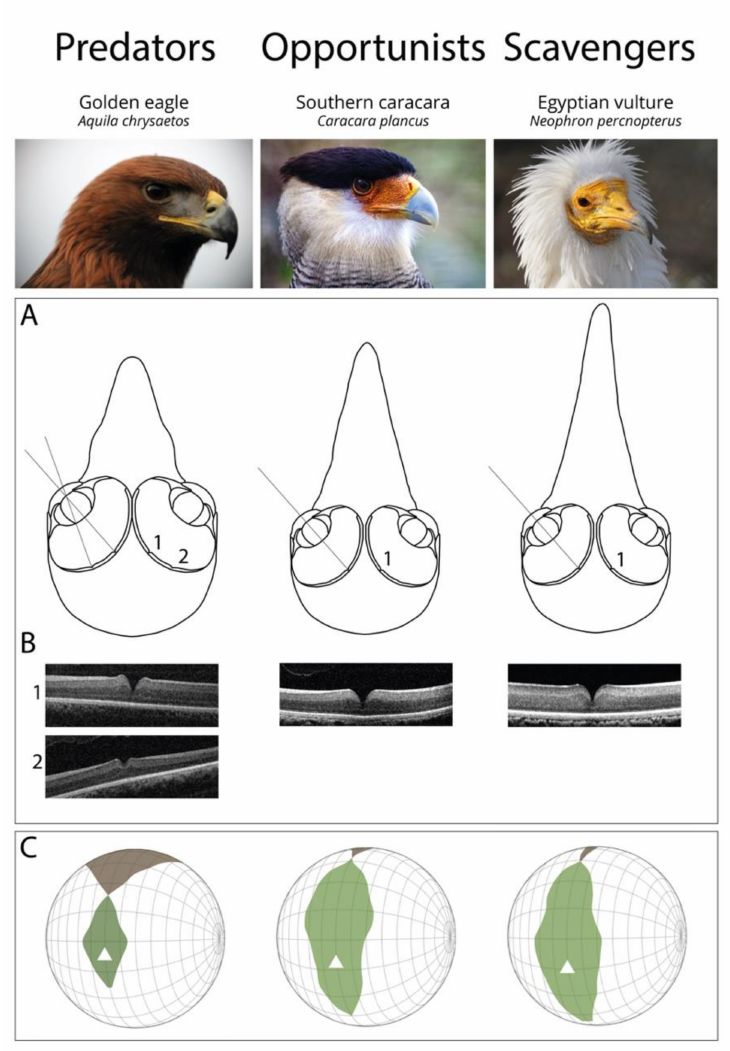
Figure 2. Functional di ff erences of the visual system of raptors from di ff erent foraging tactics. ( A ) Schematic representation of frontal sections of the three chosen species (Golden eagle Aquila chrysaetos , Southern caracara Caracara plancus , and Egyptian vulture Neoprhon percnopterus ) at the foveal plane. Fovea(s) and the centre of the pupil in each eye are on the plane. Grey lines represent the lines of sight of (1) the deep central fovea and (2) the shallow temporal fovea. Figures re-drawn from [28]. ( B ) Spectral domain optical coherence tomography (SD-OCT) images (B-scans) of the (1) central and (2) temporal fovea(s). Note that the Southern caracara and the Egyptian vulture lack temporal foveas. ( C ) Orthographic projection of retinal field boundaries of the eyes. A latitude and longitude coordinate system was used with the equator aligned vertically in the median sagittal plane (20 deg intervals in latitude and 10 deg intervals in longitude). The bird’s head is at the centre of the globe. Green areas represent the binocular sector, white areas represent the monocular sectors, and brown areas represent the blind sectors. Triangles: direction of bill projection. Figures modified from [29,30]. Photography of the species was free of right thanks to @myb777_photography for the Golden eagle, @wal_172619 for the Southern caracara, and @pixel_mixer for the Egyptian